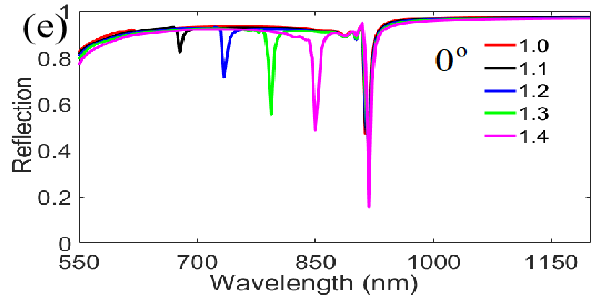
Figure 6. Investigation of sensing performance for TM polarized incidence on the top with different RIs at θ = 0 ◦ ∼ 30 ◦ . Linear response of the resonant wavelength for ( a ) 0 ◦ , ( b ) 10 ◦ , ( c ) 20 ◦ and ( d ) 30 ◦ ; ( e ) Reflection spectra with different RIs at θ = 0 ◦ . Table 1. Comparison of sensing capabilities with earlier reported works based on nanograting.